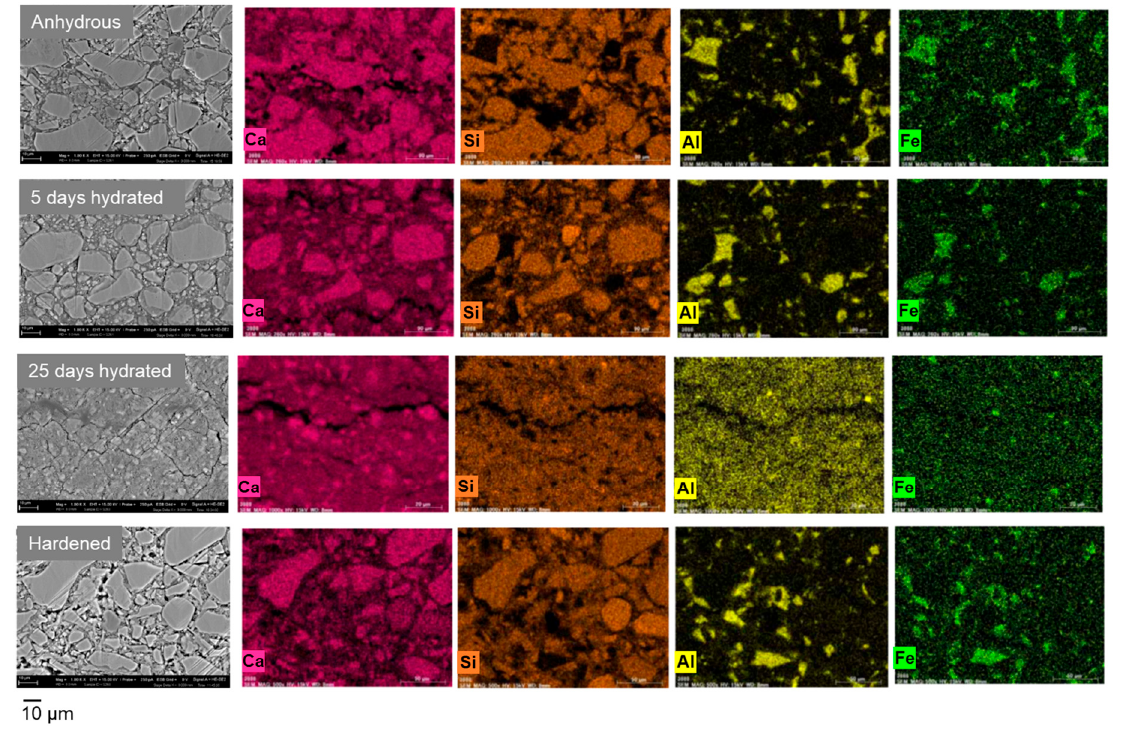
Figure 3. SEM images and energy dispersive X-ray (EDX) elemental maps for Ca, Si, Al, and Fe on the cross section of anhydrous, 5 days and 25 days hydrated, and hardened hydrated cement samples.